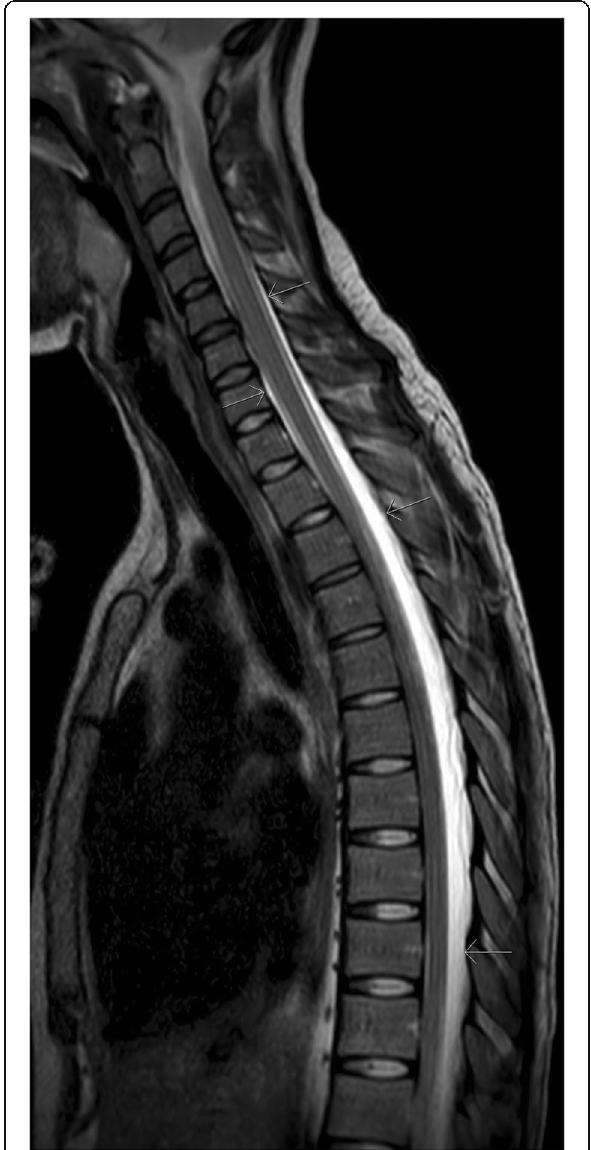
Fig. 1 MRI (T2-weighted), upper spine, sagittal: Accumulated CSF